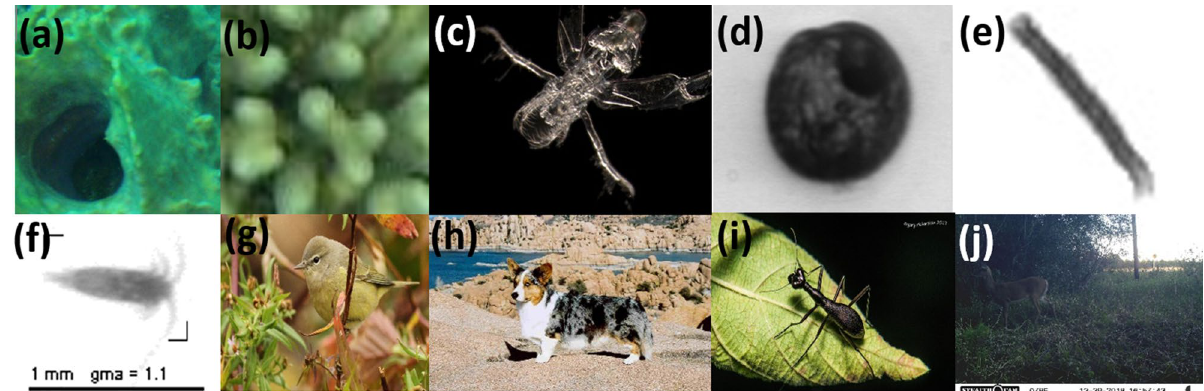
Figure 4. Examples of images from each of the datasets.( a ) RSMAS ( b ) EILAT ( c ) ZooLake ( d ) WHOI ( e ) Kaggle ( f ) ZooScan ( g ) NA-Birds ( h ) Stanford dogs ( i ) SriLankan Beetles ( j ) Florida